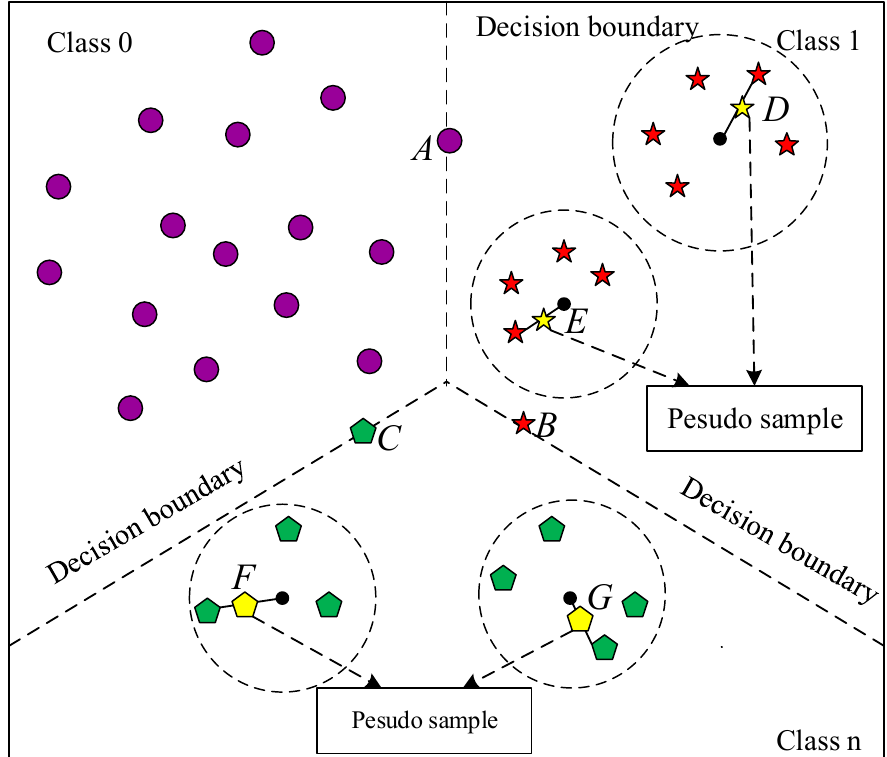
Figure 3. The construction method of the pseudo sample database.